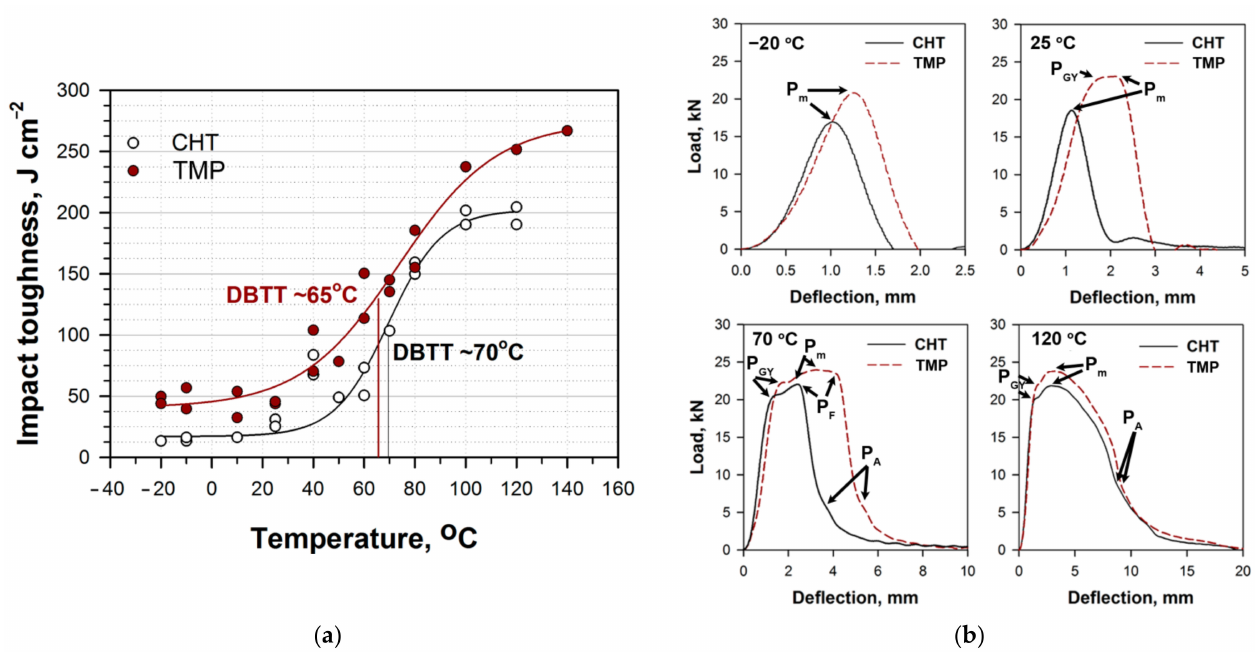
Figure 10. ( a ) Temperature dependence of Charpy energy; ( b ) the load vs. deflection curves obtained from impact tests at different temperatures for the 12% Cr steel after the CHT and TMP regimens. After CHT, the value of the upper shelf energy of the present 12% Cr steel was 200 J cm − 2 (Figure 10a). The lower shelf region was observed below 25 ◦ C; the transition region was revealed at temperatures ranging from 25 ◦ C to 120 ◦ C and the upper shelf region was located above 120 ◦ C. The value of the lower shelf region was 15 J cm − 2 (Figure 10a). The DBTT, calculated as the temperature corresponding to the impact energy absorption halfway